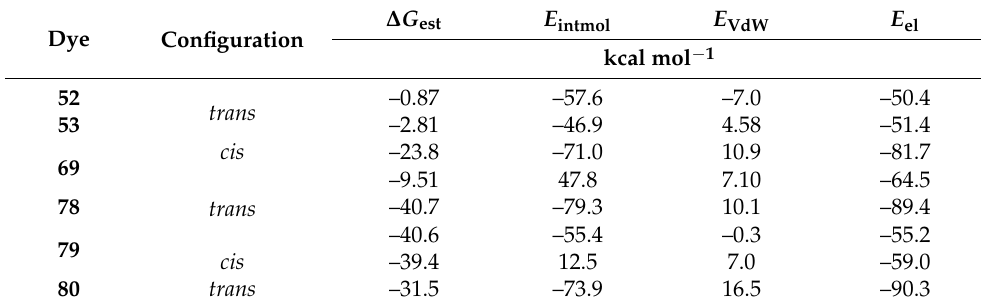
Table 3. Values of free energy of binding ( ∆ G est , kcal mol − 1 , at 25 ◦ C), intermolecular energy ( E intmol , kcal mol − 1 ), van der Waals energy ( E VdW , kcal mol − 1 ), and electrostatic energy ( E el , kcal mol − 1 ) for docking cyanine dye with HSA.